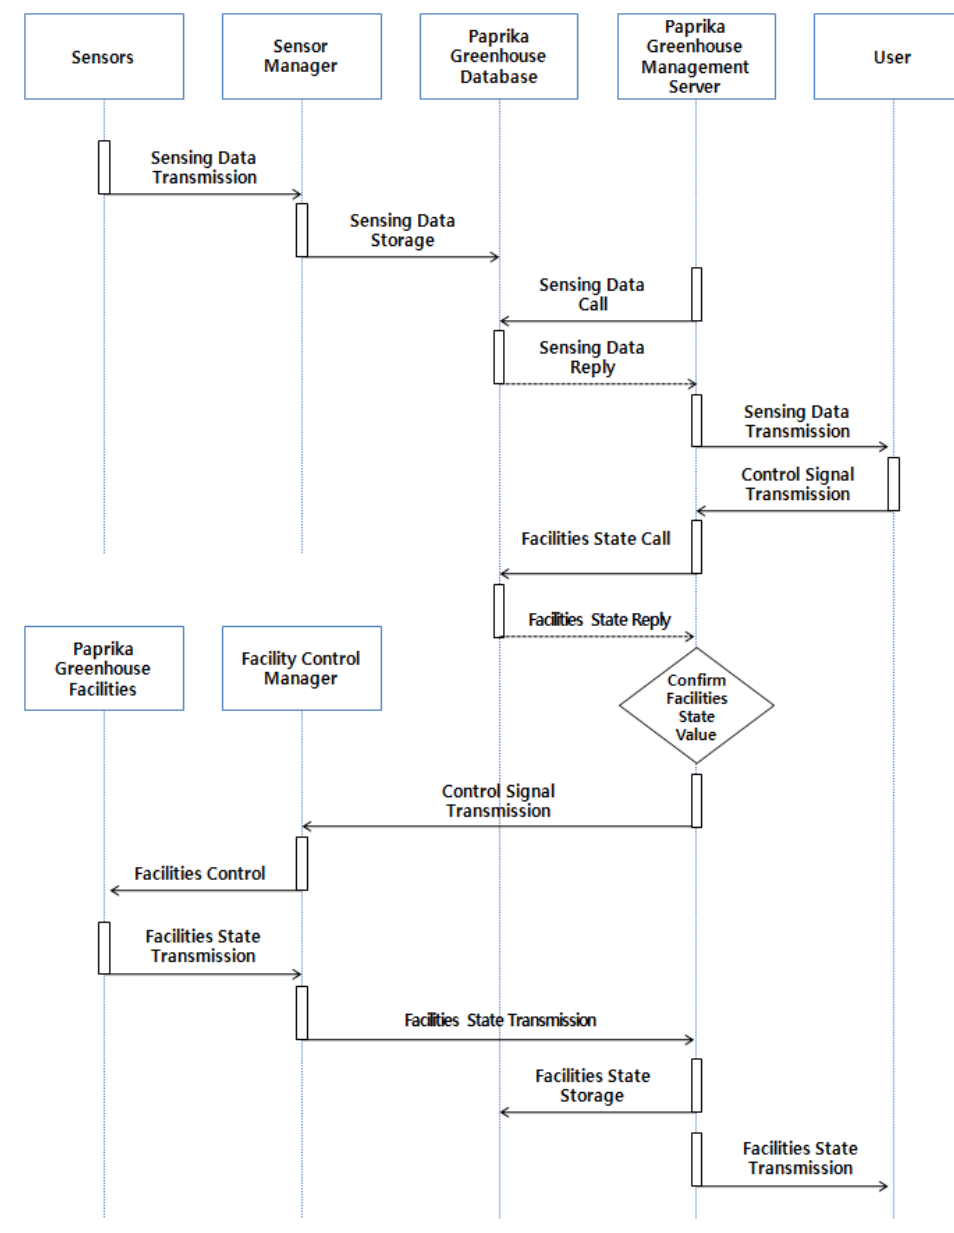
Figure 5. Paprika Facilities Manual Control Services